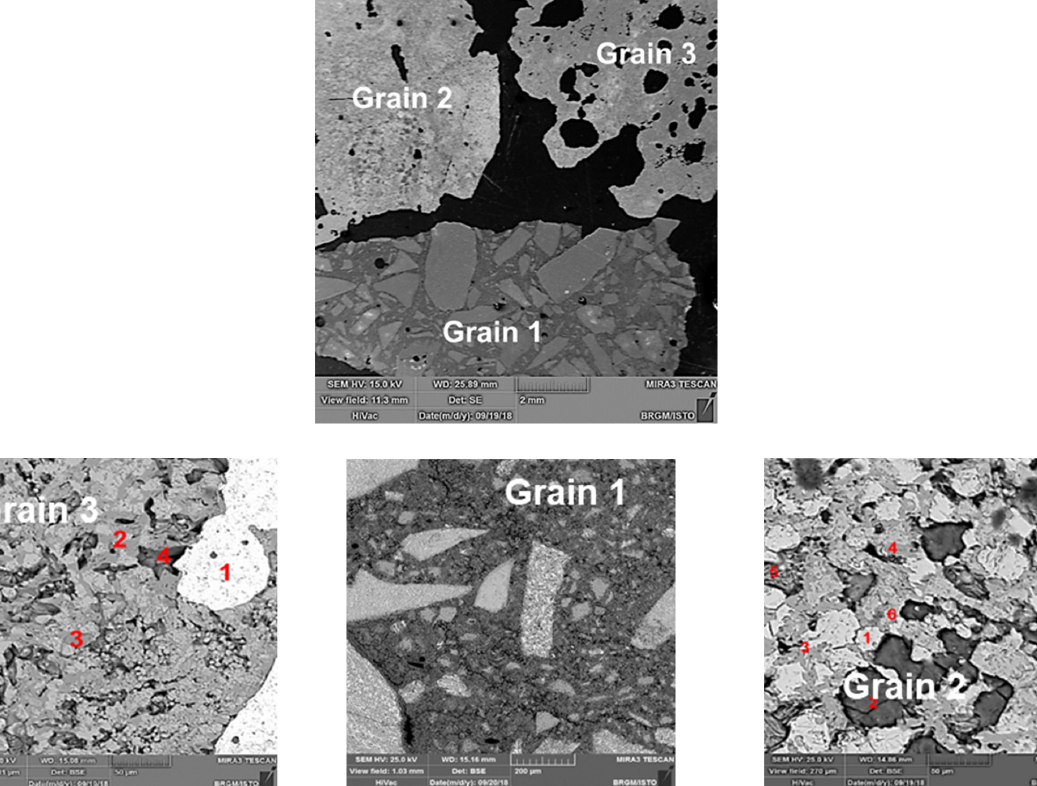
Figure 6. Morphological characterization by scanning electron microscopy of three different grains of the EAF slag sample. Numbers 1 to 6 indicate the spots for EDS analysis [26].